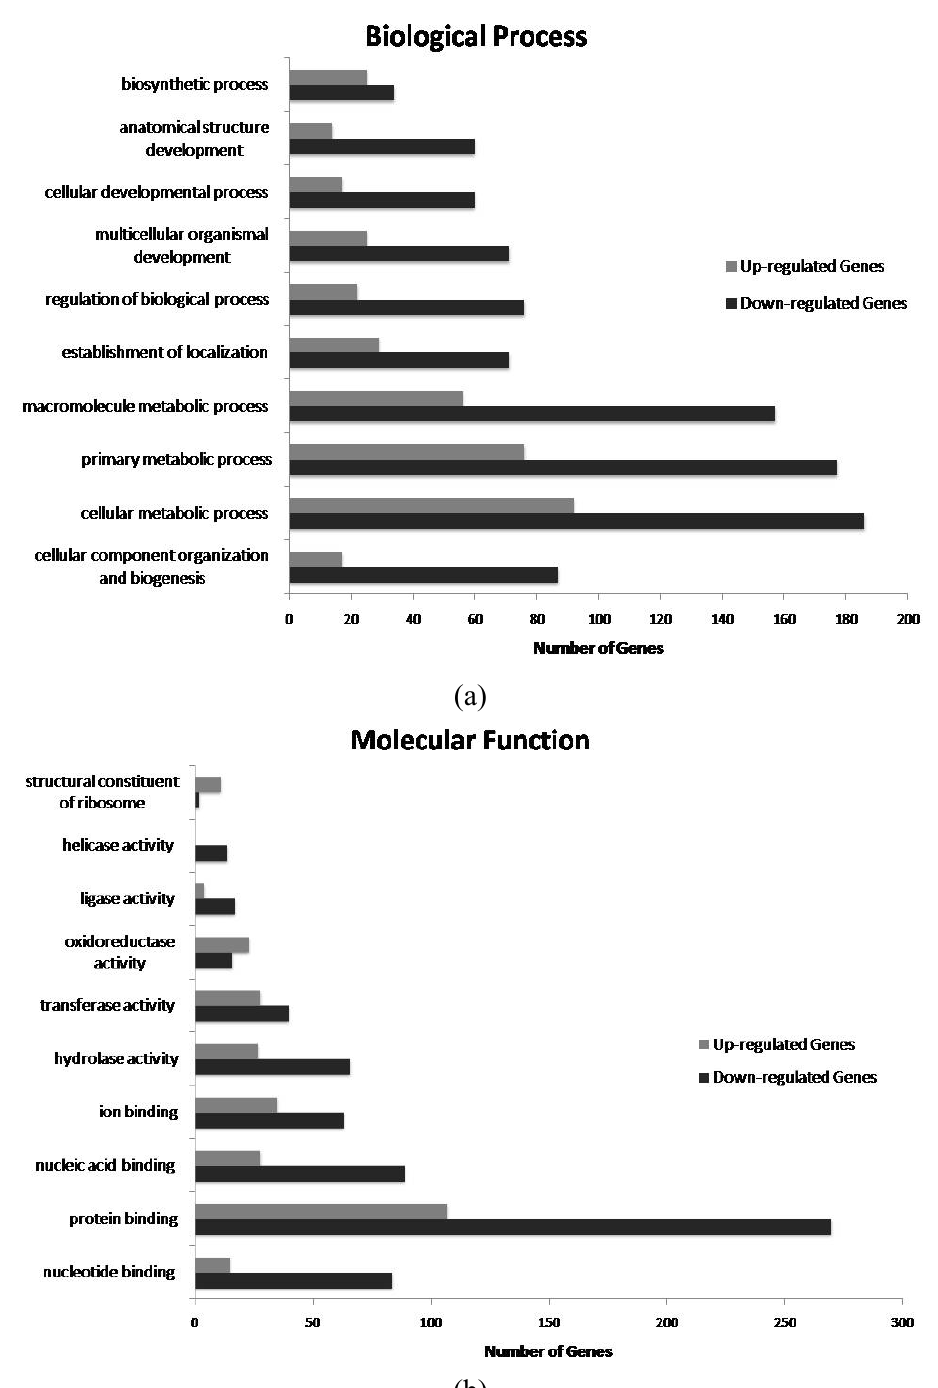
Figure 1. Top 10 Gene Ontology categories representing the major (a) Biological Processes and (b) Molecular Functions affected by dsRNA-GFP treatment during honey bee workers development. For each category (Y axis), the number of down- and up-regulated genes are reported (X